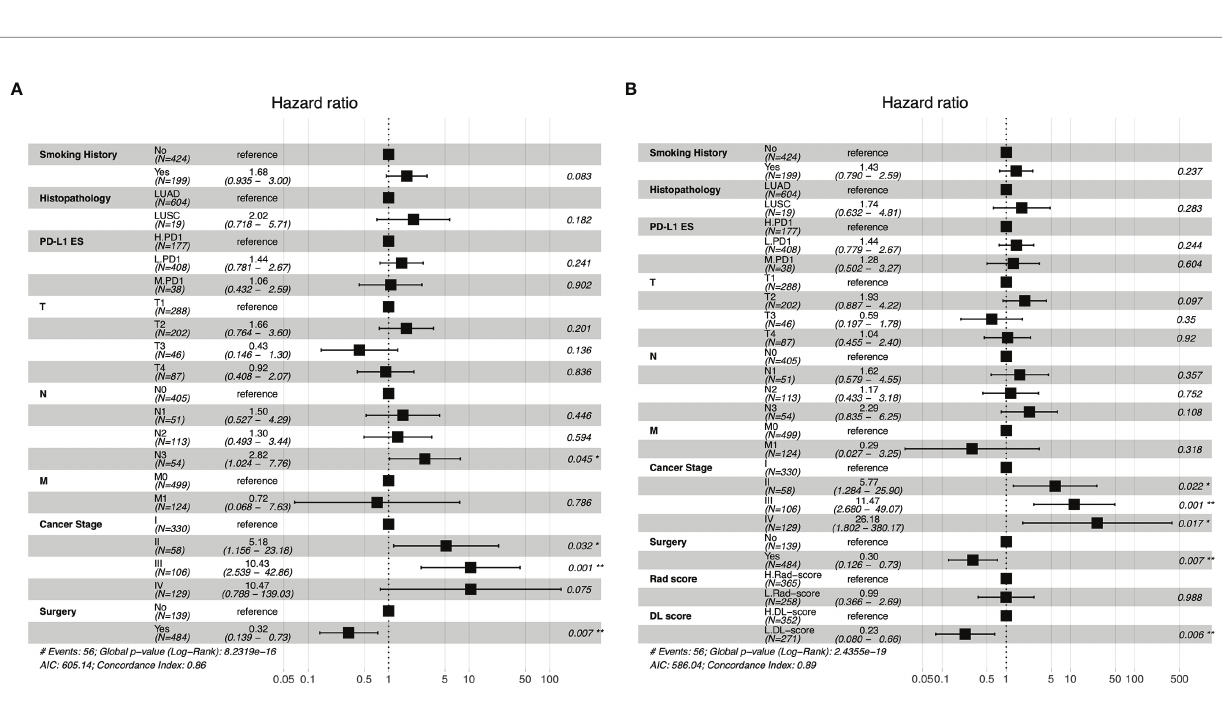
FIGURE 4 | Forest plots of clinical model (A) , the combination model with radiomics score and deep learning score (B) . PD-L1ES, PD-L1 expression signature; LUAD, lung adenocarcinoma; LUSC, lung squamous cell carcinoma; Rad, radiomics; DL, deep